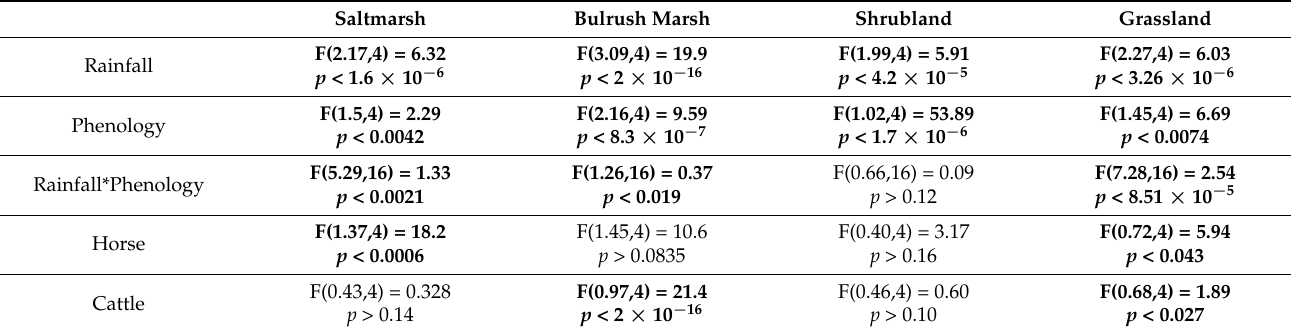
Table 3. Significance tests and probability levels of the GAM models predicting plant production (peak NDVI), fitted separately for each vegetation type. Only the predictor variables included in the “best” model are shown. “Adjusted-R squared” and “Deviance explained” refer to the results of the full model, including all variables (i.e., those with significant and with non-significant